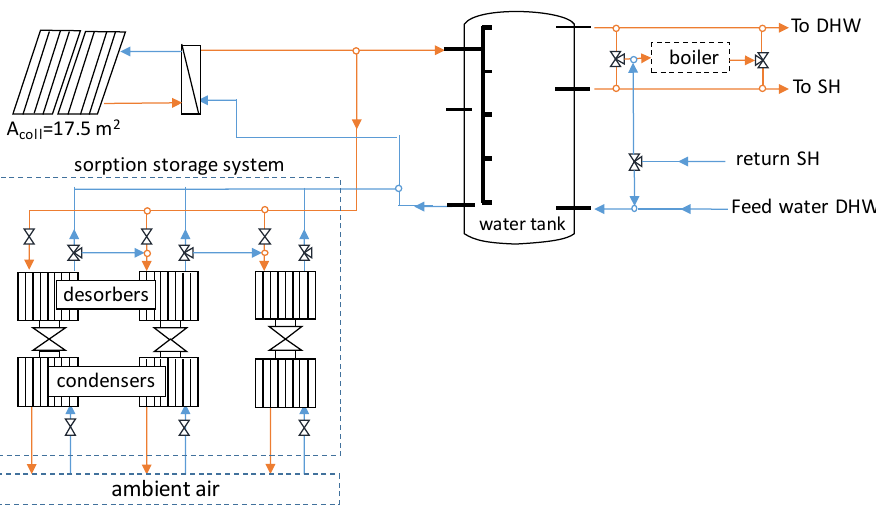
Figure 2. Schematic of the system for summer configuration.